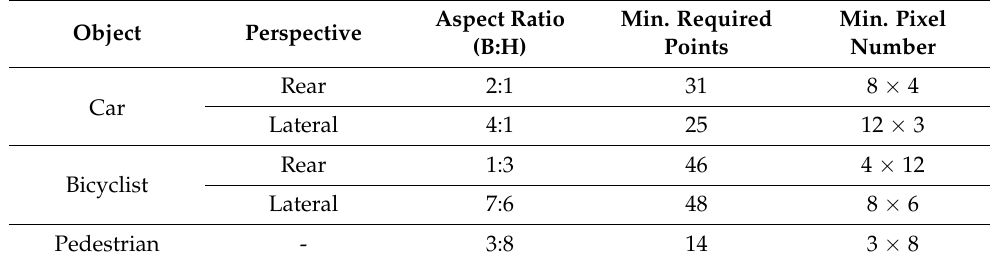
Table 6. Minimum pixel number to detect main traffic targets under a confidence score of 0.5.